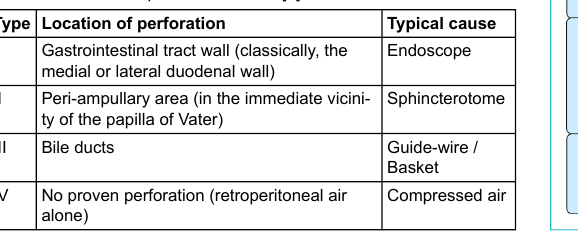
Table 1: Modified Stapfer classification [4].